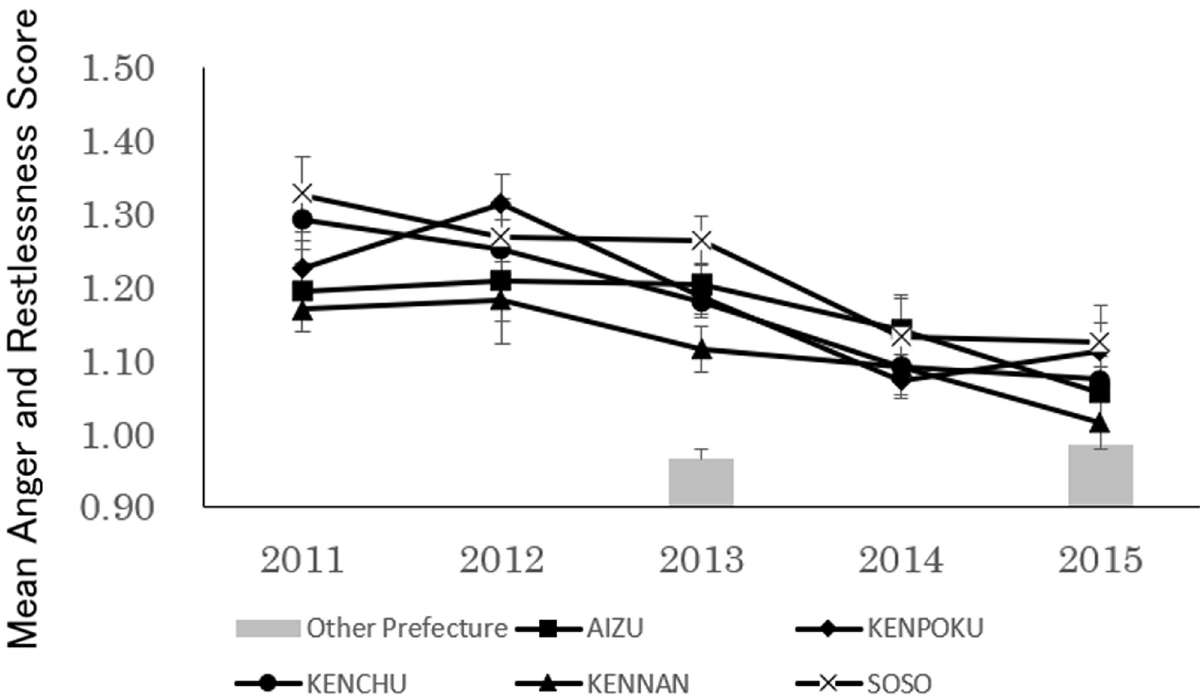
Fig 6. Transition over time in anger and restlessness (Mean ± SE) of 18 and 42-month-old children in low-contamination regions.